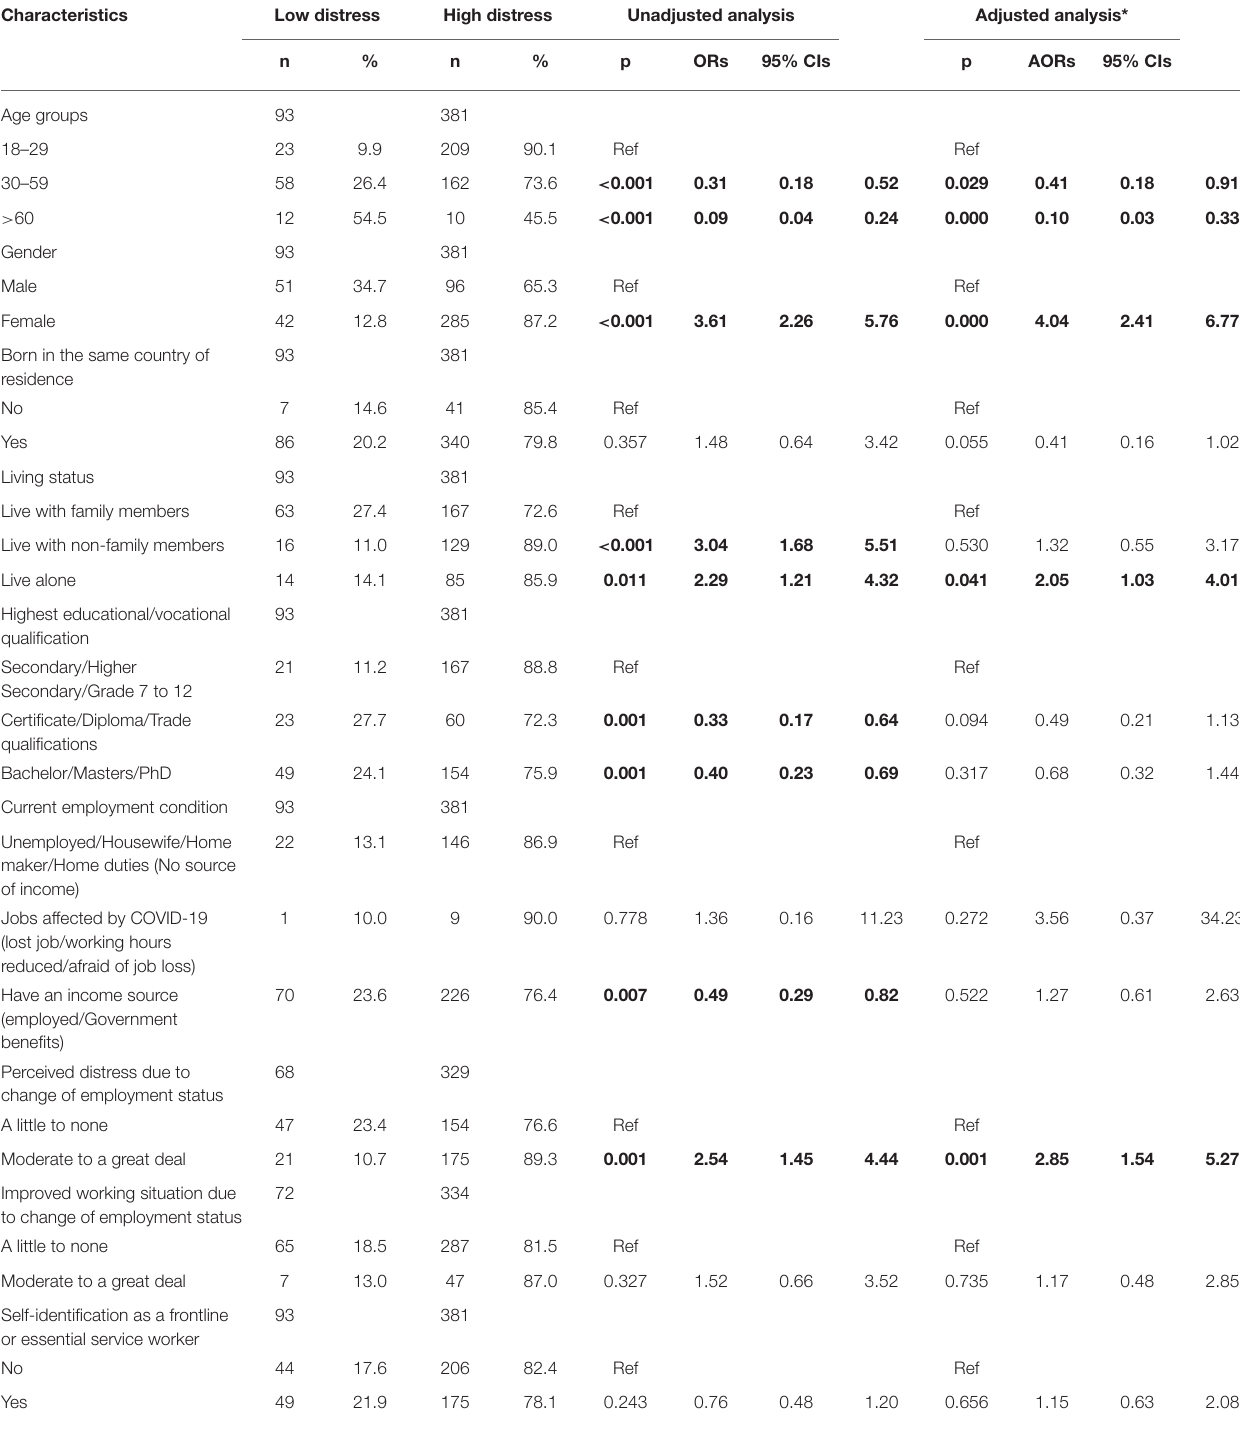
TABLE 2 | Factors associated with high psychological distress among the study population (based on K10 scoring). Characteristics Low distress High distress Unadjusted analysis Adjusted